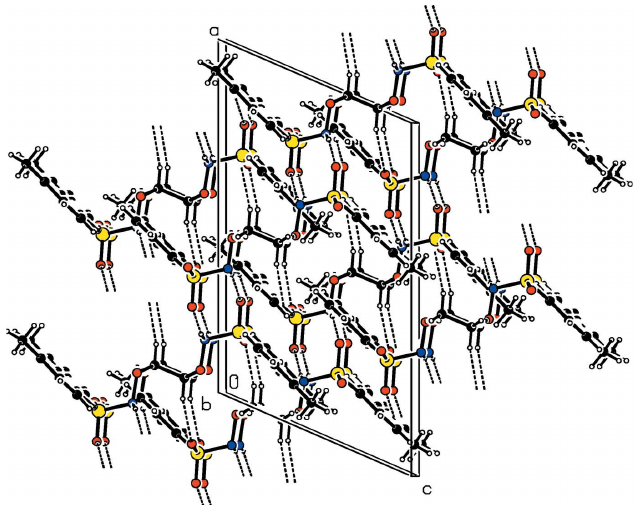
Figure 3 A view along the b -axis of the crystal packing of the title compound. The hydrogen bonds (Table 1) are shown as dashed